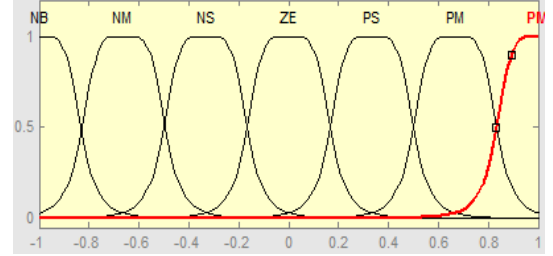
Figure 3. Membership functions of the input